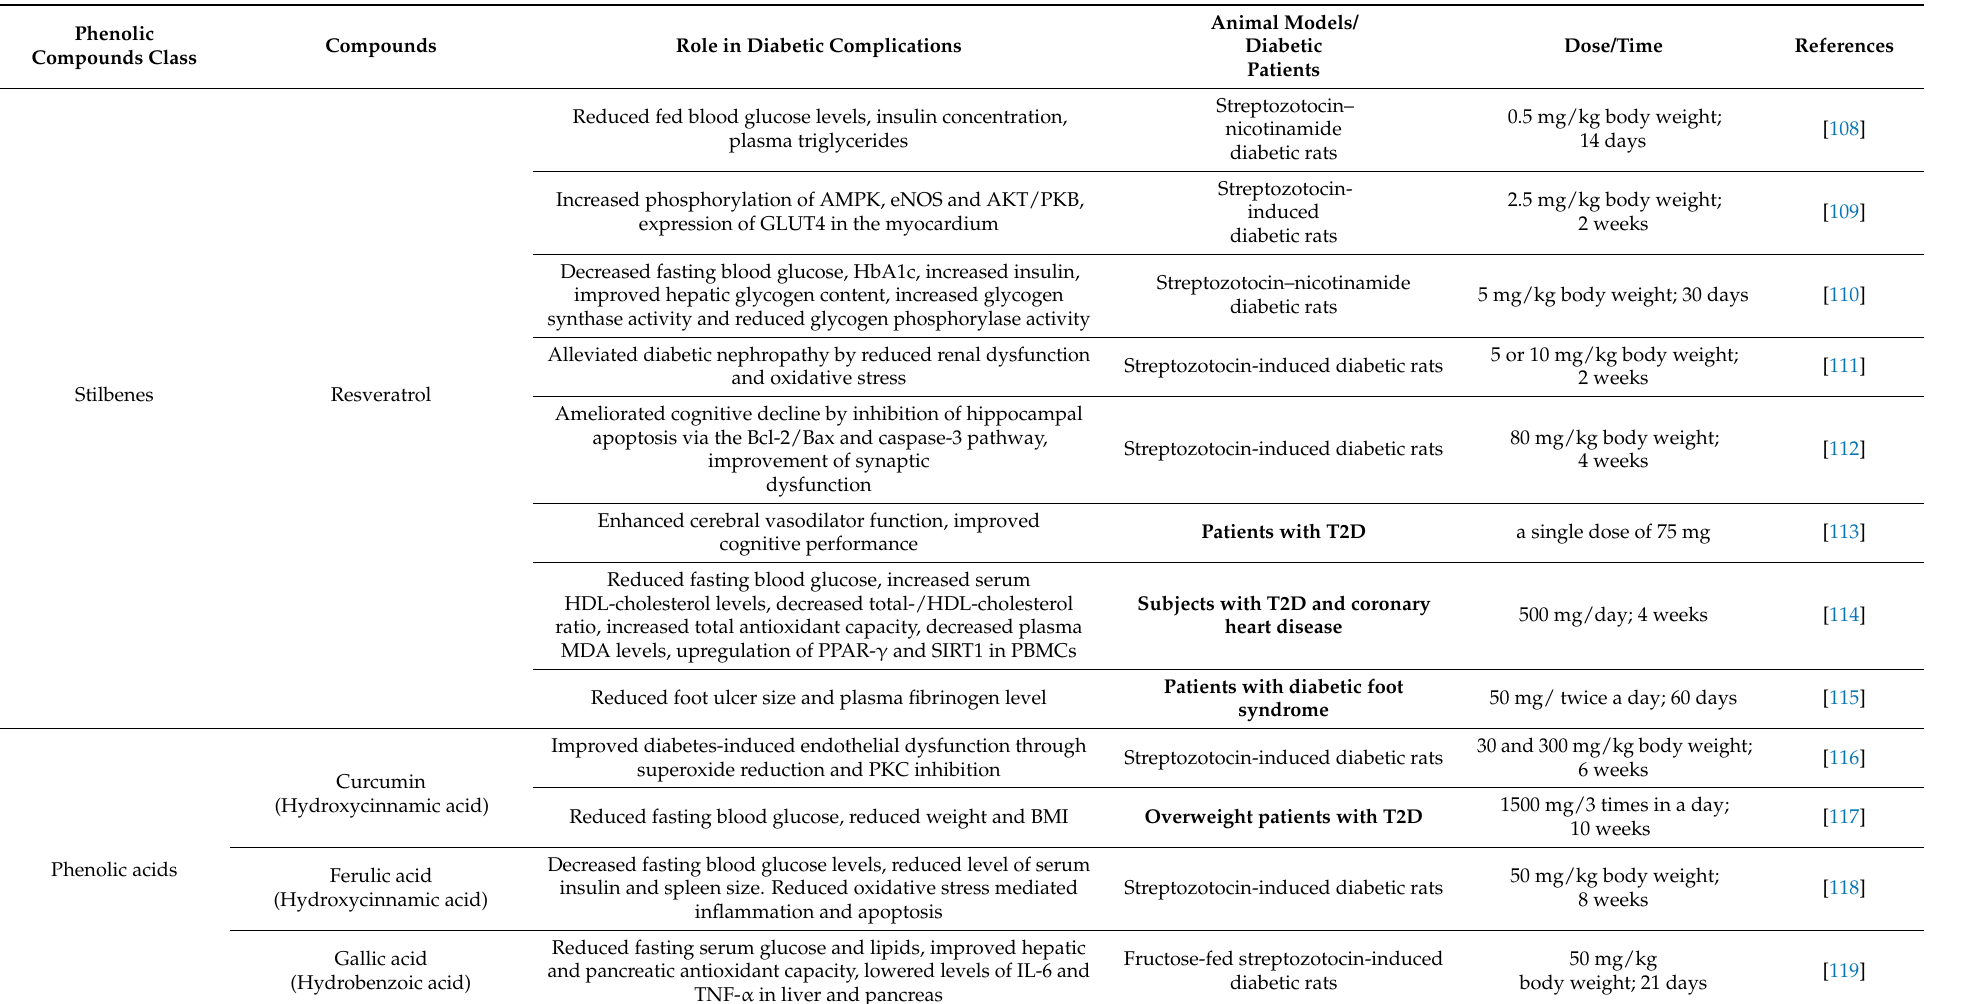
Table 1. A summary of individual phenolic compounds or extracts possessing antidiabetic effects in pre-clinical and clinical